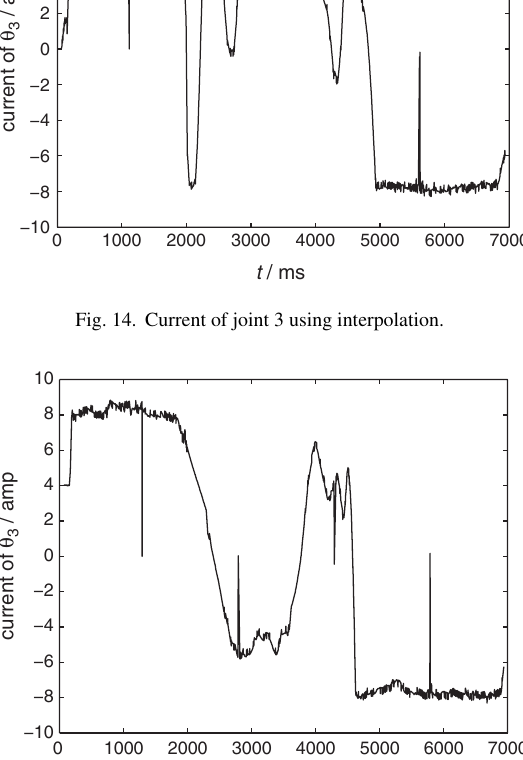
Fig. 13. Current of joint 2 using geodesics.